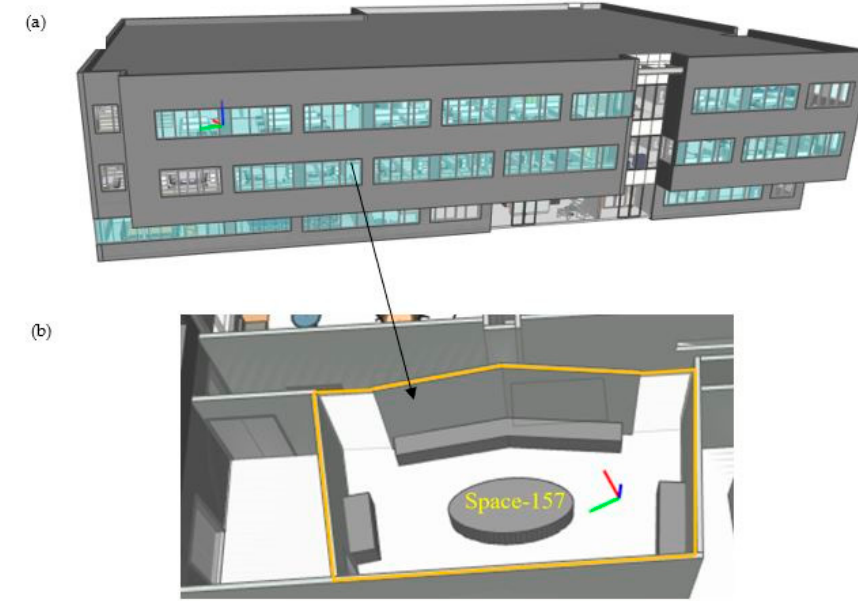
Figure 14. ( a ) The 3D IFC Model of Test Case; ( b ) the TheNon-Perpendicular Room (Space-157).